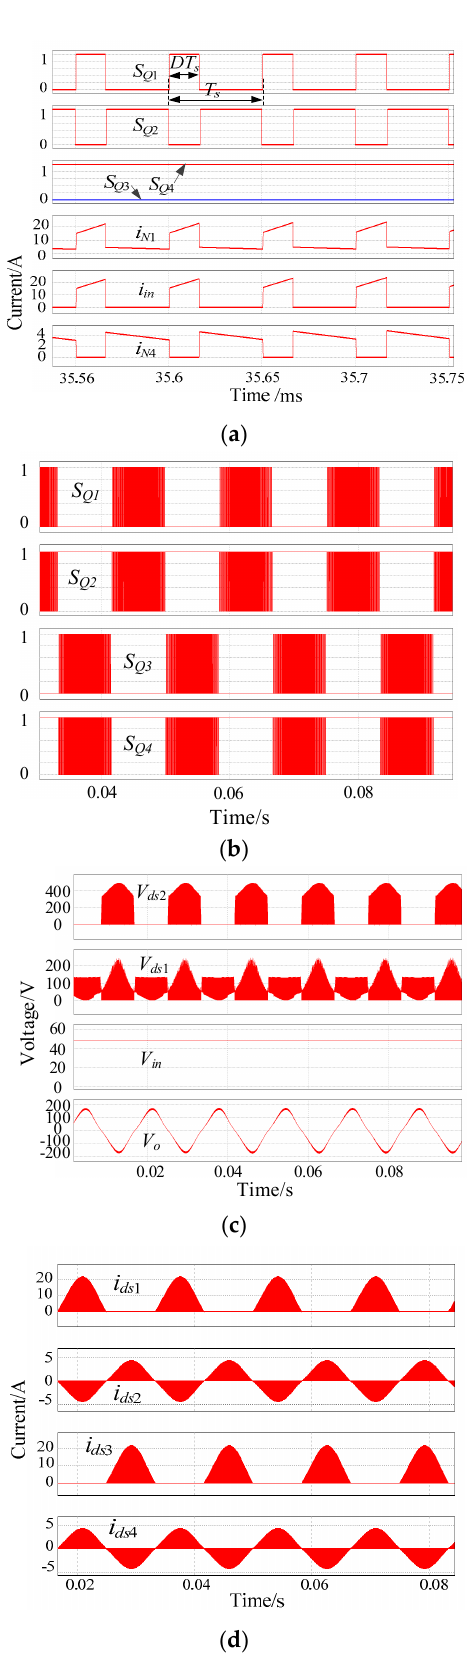
Figure 7. Key simulation waveforms of the proposed SSBBI: ( a ) Driving signal and currents on the switching period scale; ( b ) driving signals for switches; ( c ) V ds of the switches in one leg, input, and output voltage; ( d ) switch currents on the output period